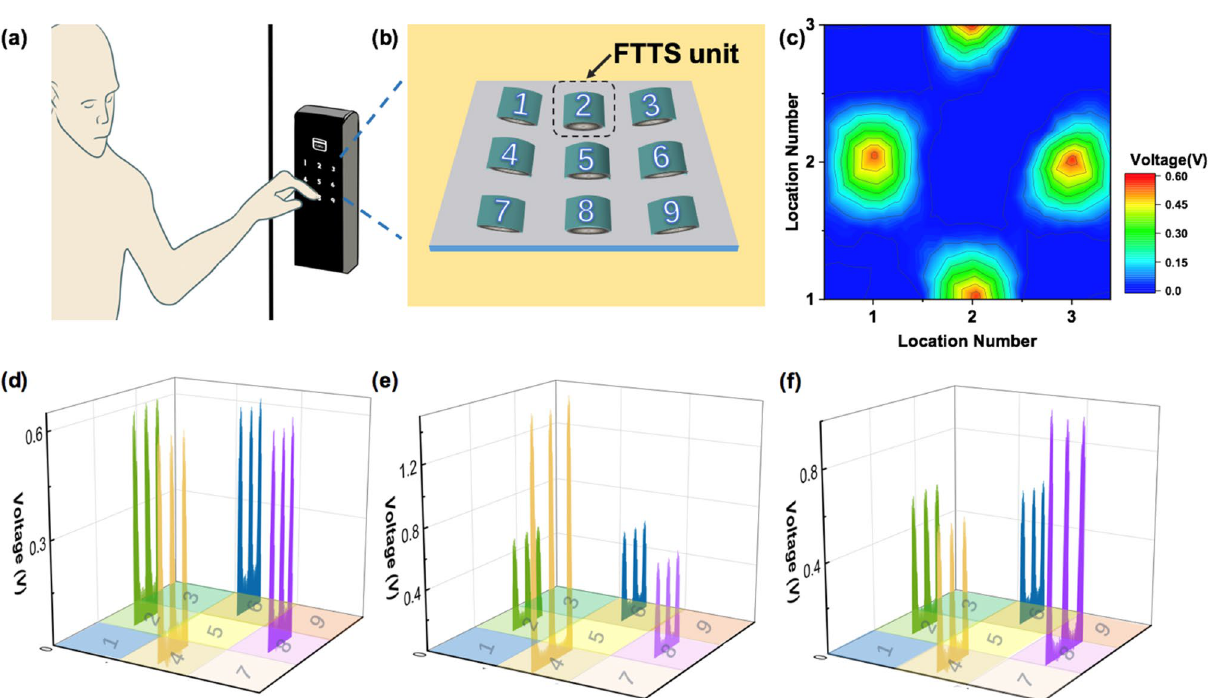
Fig. 5 Application as novel password lock with variable force requirement. a The schematic illustration of people unlocking password lock. b FTTS worked as nine-digit password lock. c The contour map of voltage with password “2468” under the same external pressing. The three- dimensional diagram of voltage with password “2468” under the same external pressing with d all the same D = 0 mm, e one different D = 4 mm at “4”, f one different D = 16 mm at